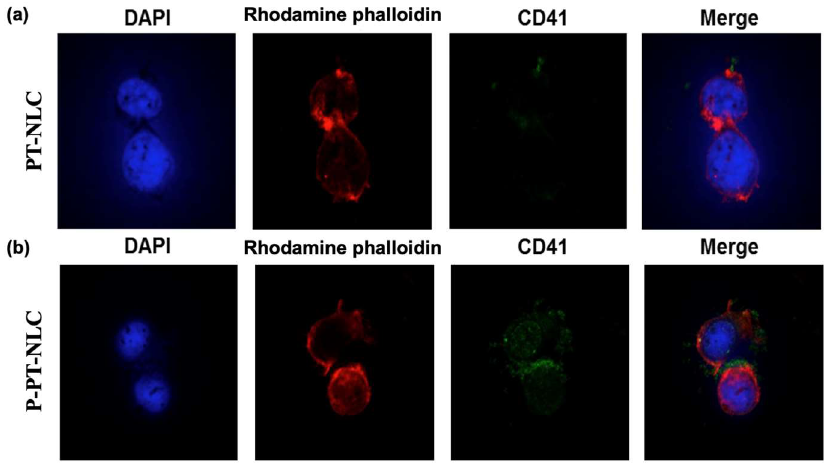
Figure 6. Confocal fluorescent microscopy images. ( a ), PT-NLC; ( b ), P-PT-NLC. After treatment with PT-NLC and P-PT-NLC, SK-OV-3 cell was stained with 4′,6-diamidino-2-phenylindole (DAPI), rhodamine–phalloidin and integrin α IIb Alexa Fluor ® 488 antibody (1:100) (blue = nuclear, red = F-actin, green = CD41).